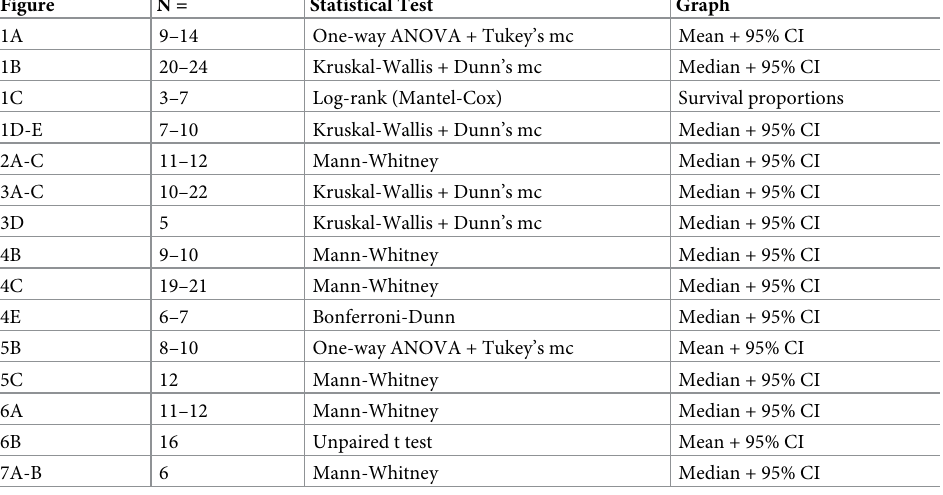
Abbreviations: mc = multiple comparison; CI = confidence